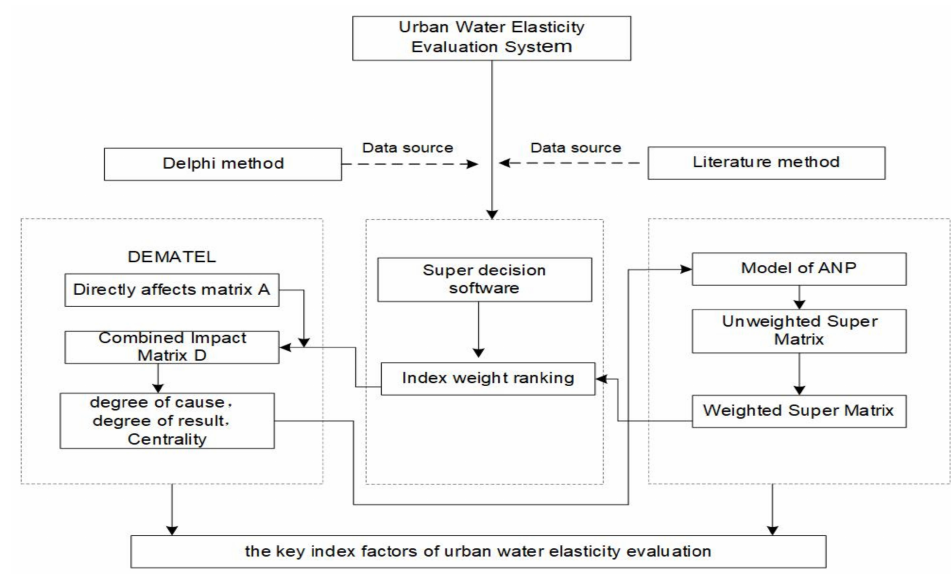
Figure 3. Evaluation model of urban water resilience based on